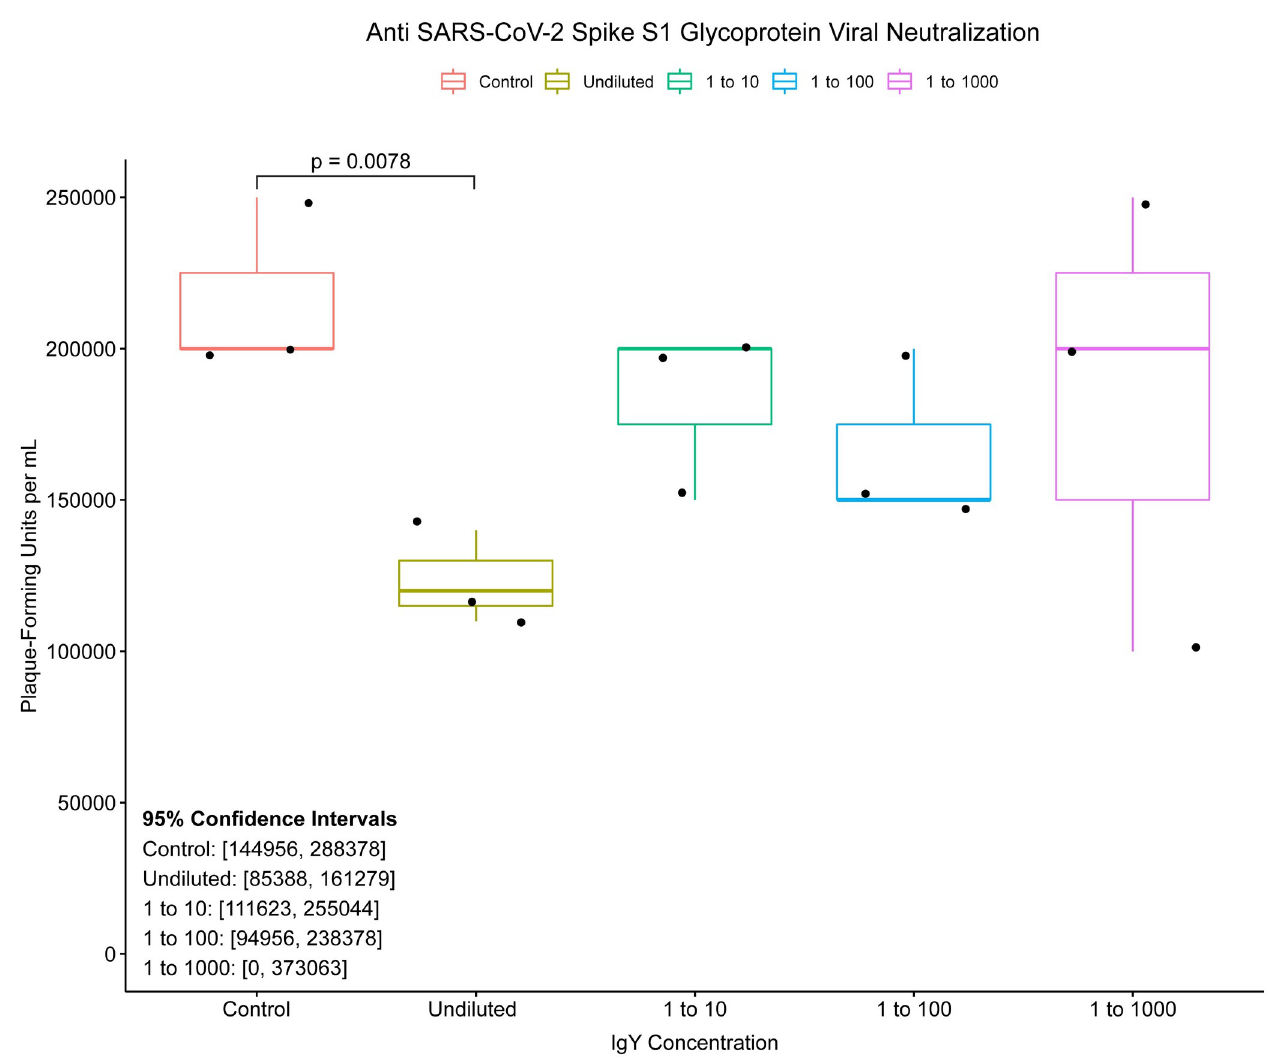
Fig 5. Box and whisker plots of SARS-CoV-2 viral replication patterns in vitro . Boxes represent interquartile range (IQR) with median shown as center bar of each sample group. Whiskers represent 1.5 times the IQR. P-value, by two-sample t-test method, and 95% confidence interval (CI) was calculated using R software package EnvStats (v.2.3.1) (Millard, 2013). Undiluted (16.8 mg/ml), and logarithmic dilutions (1.68, 0.168, and 0.0168 mg/ml) are shown. P-values less than 0.05 are shown. Coral, control IgY; gold, undiluted S1 IgY; green, S1 IgY diluted at 1:10; blue, S1 IgY diluted at 1:100; purple, S1 IgY diluted at